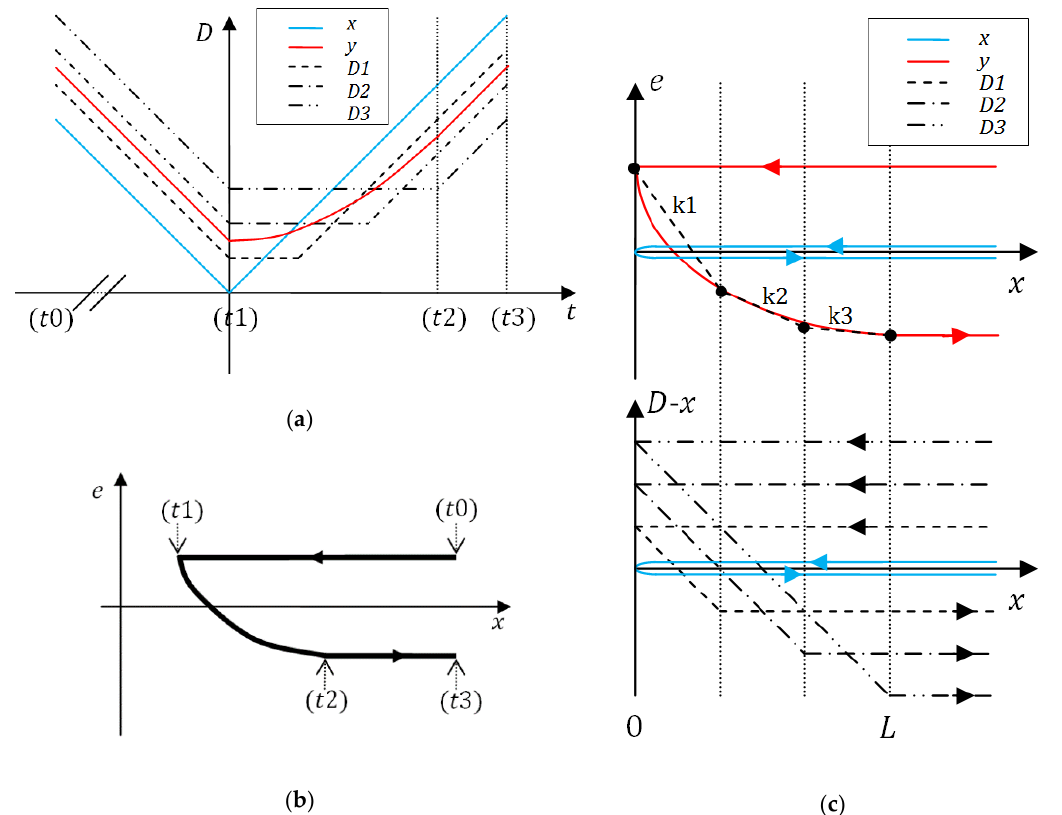
Figure 5. Data for calibration with identified critical points. ( a ) The collected signals x and y in time domain. The values of domains are shown for N = 3. ( b ) It is easier to identify critical points by observing the plot of sensor’s error e relative to the reference signal x. ( c ) The error signal e ( x ) between critical points (t1) and (t2) is split into N linear regions. Each can be expressed as a linear combination of the N domains.